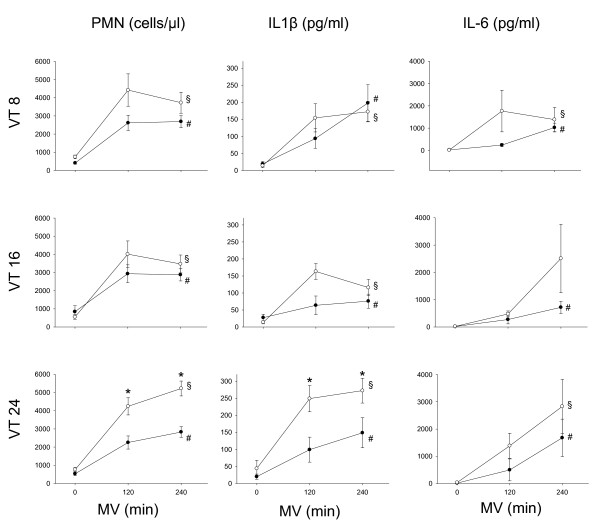
Markers of systemic inflammation during mechanical ventilation (MV) in young and old rats. Young (black circles) and old (white circles) rats were ventilated with tidal volumes (VT) of 8, 16 or 24 ml/kg, respectively. PMN, blood neutrophil counts; IL-1β, Interleukin-1β in serum; IL-6, Interleukin-6 in serum. *, P <0.05 old vs. young animals; #, §, P <0.05 time point vs. start of MV.